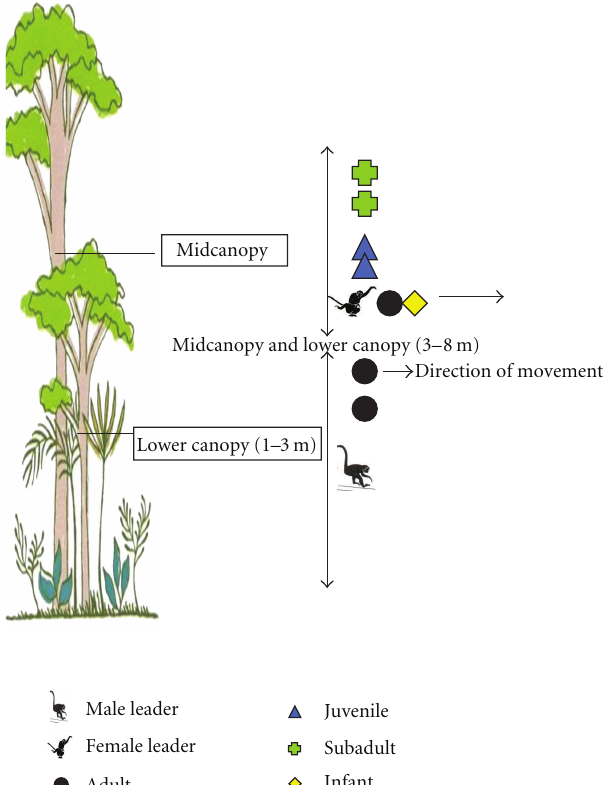
Figure 2: Illustration of vertical movement practiced by the main groups at mid- and lower canopy.